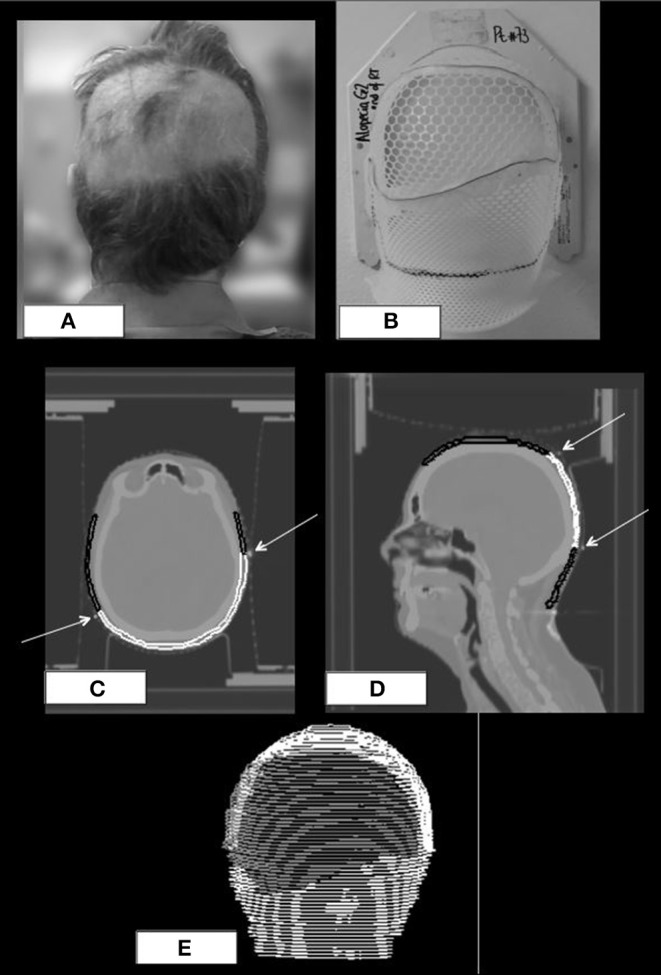
Posterior view of a patient with a wide area of G2 alopecia (A) at the end of radiotherapy; prone mask with the wire defining the area of alopecia (B); original CT simulation of the patient with coregistration of the wired prone mask (C,D); scalp ROI is black colored, area of alopecia G2 is white colored, white arrows indicate the wire on the mask. 3D-view of the same patient at the treatment planning (E).